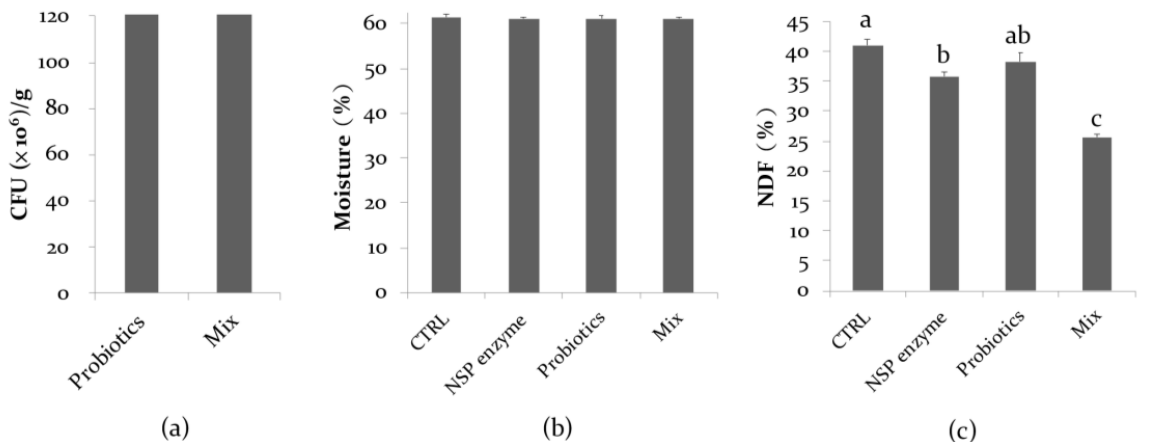
Figure 2. Effect of the NSPase supplementation on total Lactobacillus viable count ( a ); water contents ( b ); and neutral detergent fiber contents ( c ) of okara and CM fermentation under vari- ous fermentation product contents. Mixed okara and copra meal (control, CTRL), mixed okara and copra meal plus exogenous NSPases (NSP enzyme), mixed okara and copra meal plus probiotics (Probiotics), mixed okara and copra meal plus probiotics and NSPases (mixed). Values are expressed as mean ± SD ( n = 3). a–c Means of different fermentation during time treatment with different superscript letters are significantly different at p < 0.05.